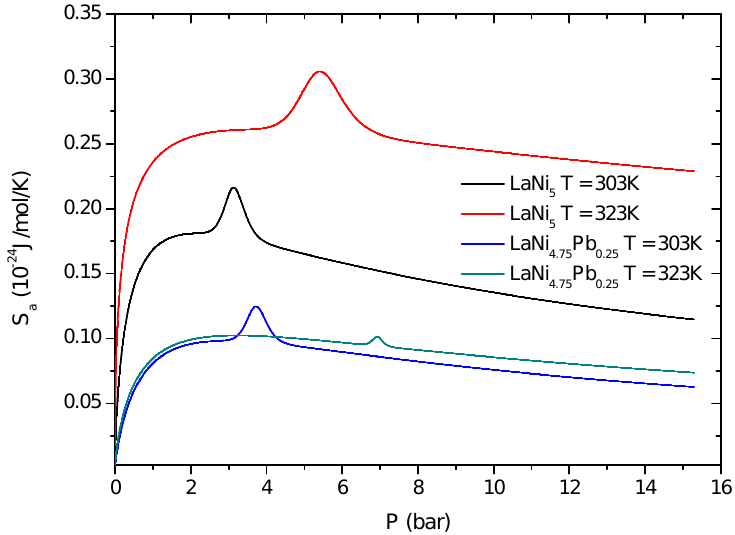
Figure 12. Evolution of the overall absorption entropy versus pressure at T = 303 K, T = 323 K for LaNi 5 and LaNi 4.75 Pb 0.25 (Equation